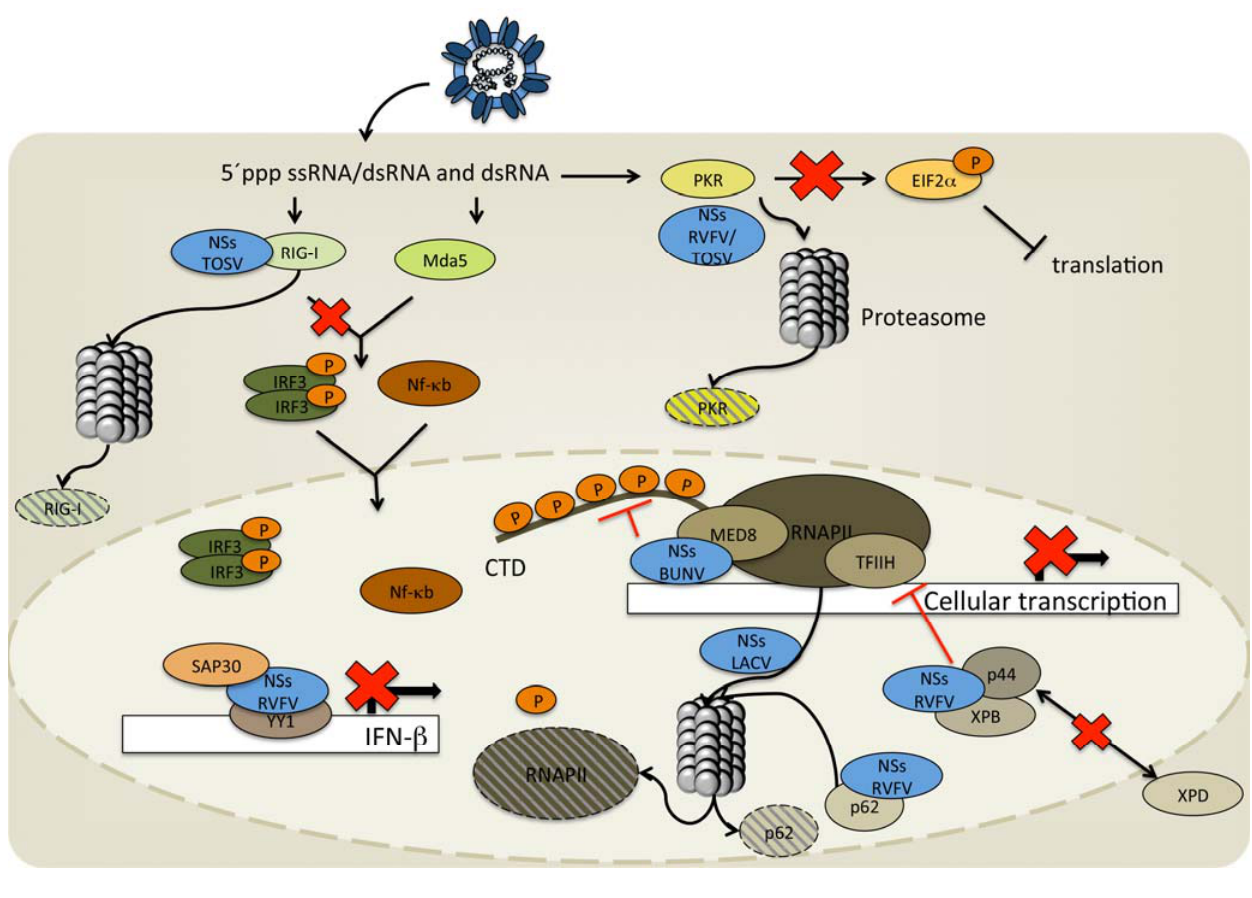
Figure 3. The mechanisms by which NSs of orthobunyaviruses and phleboviruses interfere with the host innate immune system. The NSs proteins of the different bunyaviruses display a variety of different mechanisms to interfere with the host antiviral defense. This is done both by inducing proteasome degradation of proteins such as PKR and RIG-I as well as interfering with the assembly and activation of the transcription machinery inducing a host cell transcription block and inhibiting IFN- β